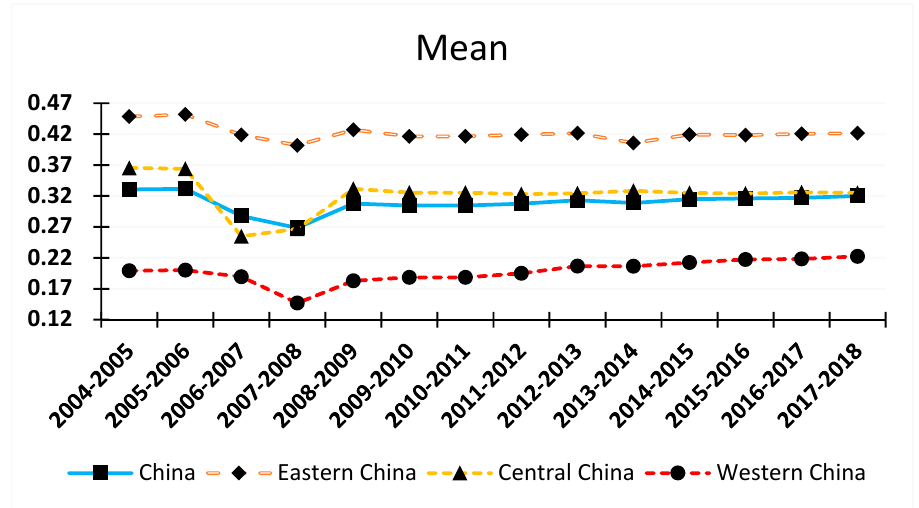
Figure 1. Mean Values of HCR Concentration at National and Regional Levels (Eastern, Central, and Western Regions).